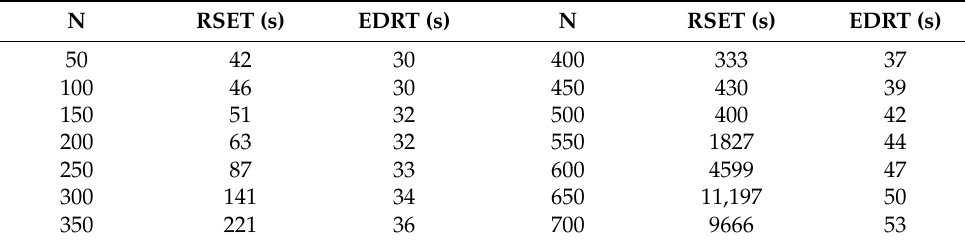
Table 6. Relationship between the number of evacuees and evacuation time.